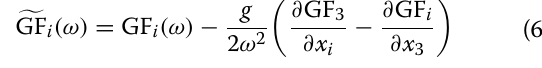
Locations are derived from 1-min moving time window with no overlap. Time is in UTC at the start of each window. The lateral and depth errors are in meters. See Figs. 3, 4 and 5 for